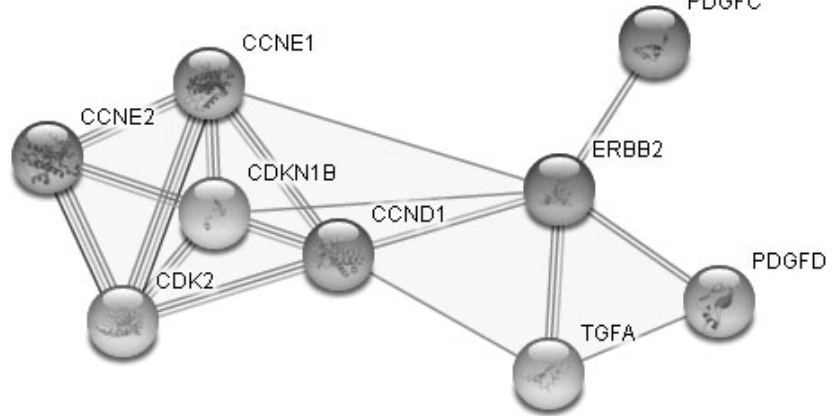
Figure 4. Target genes for miR-660, miR-30e, miR-125b, miR-205, miR-375, miR-378, miR-19b and miR-425, which are involved in prostate cancerogenesis. PANTHER data: GO-Slim Biologic Process.